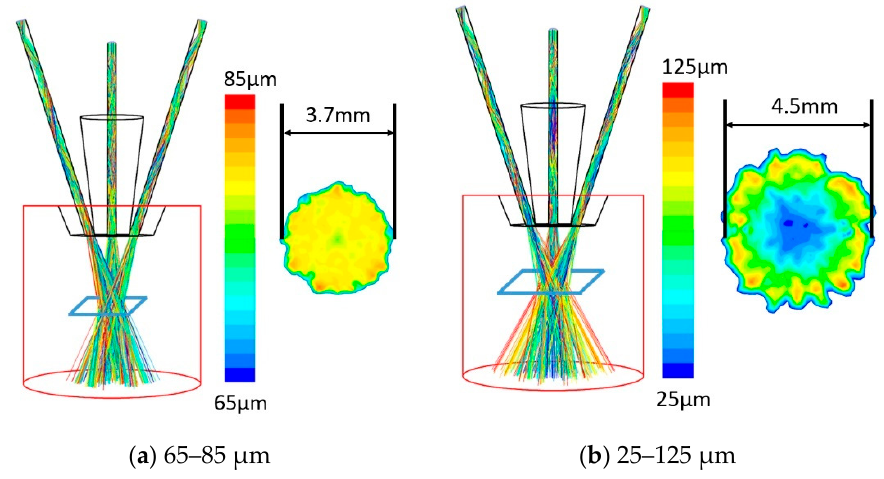
Figure 10. Particle sizes distribution in powder stream for coaxial-discrete nozzle. ( a ) 65–85 μ m; ( b ) 25–125 μ m.